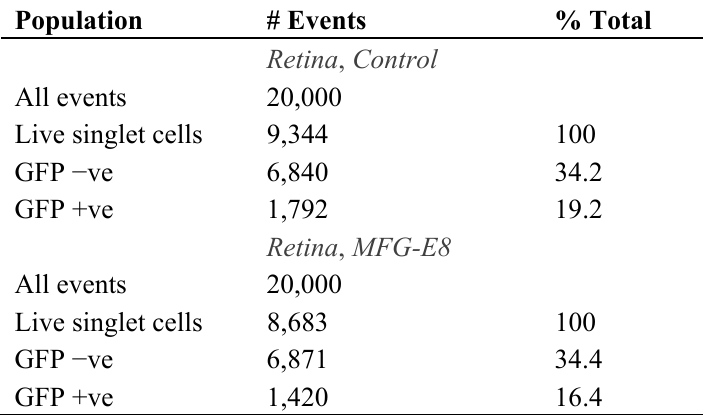
Table 1. Cell numbers from FACS analysis of AAV subretinal transduction with increased levels of MFG-E8. The number of cells that are transduced (GFP +ve) or not (GFP − ve) by virus expressing eGFP are